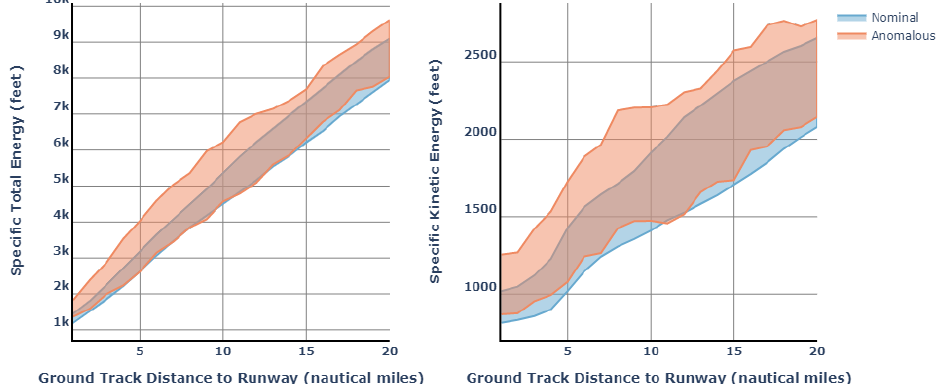
Figure 9. Comparison of specific energy at different ground track distance points from the runway prior to the go-around.